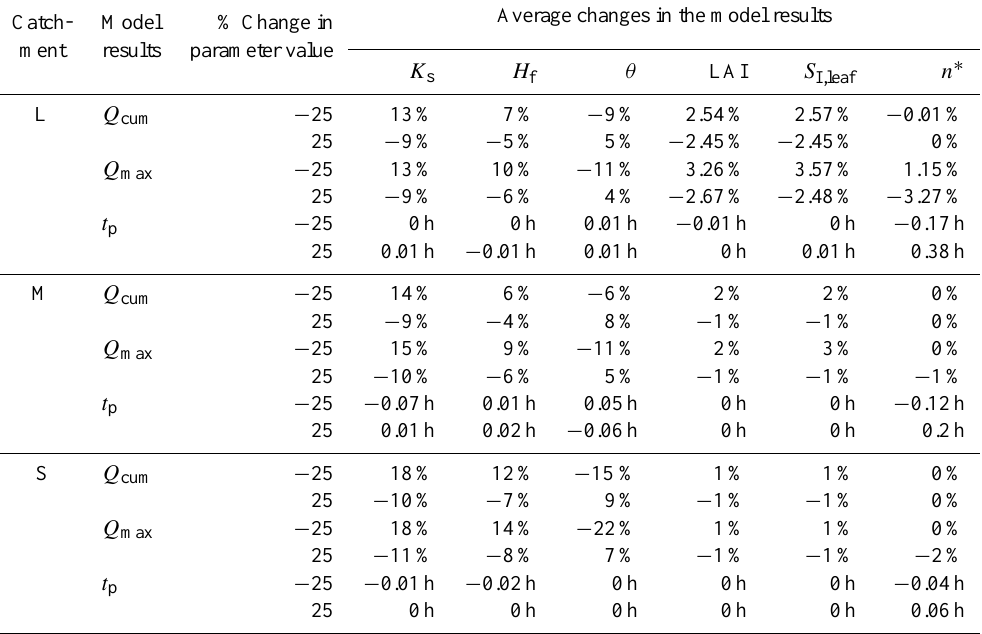
Table 6. Sensitivity of the model results with the closure relation C . Values are averaged over all events ( n = 13). Average changes in the model results Catch- Model % Change in ment results parameter value K s H f θ LAI S I,leaf n ∗ L Q